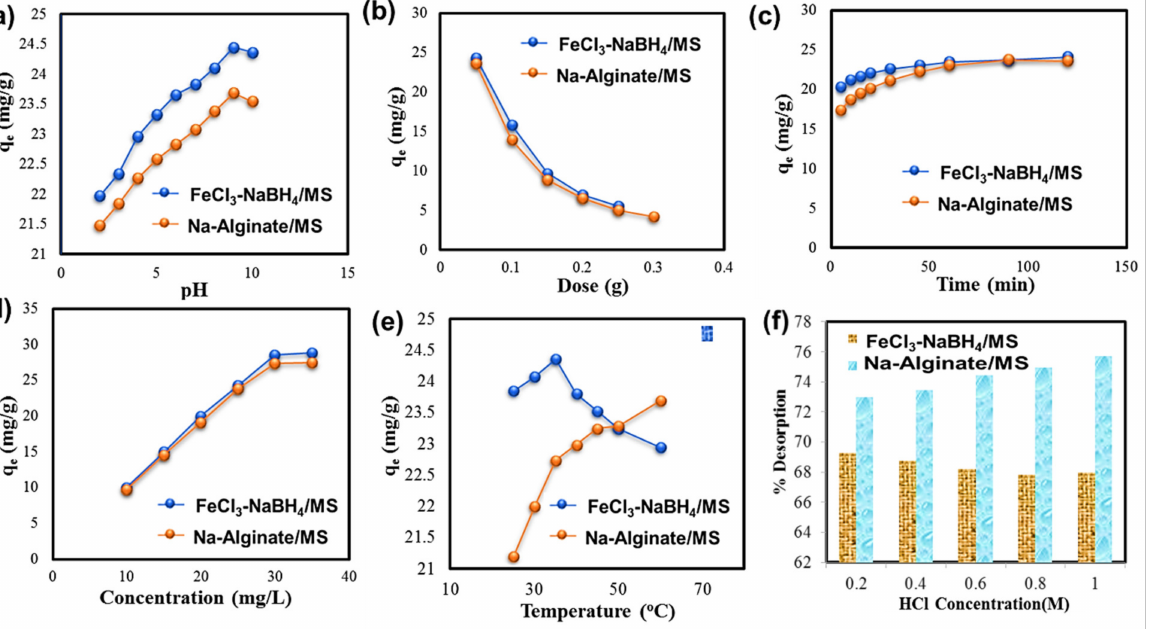
Figure 3. Influence of ( a ) pH, ( b ) dose, ( c ) contact time, ( d ) 2,4,6-TCP initial concentration, and ( e ) temperature on 2,4,6-TCP adsorption capacities of adsorbents and ( f ) 2,4,6-TCP contaminant desorption efficiency of adsorbents in desorbing